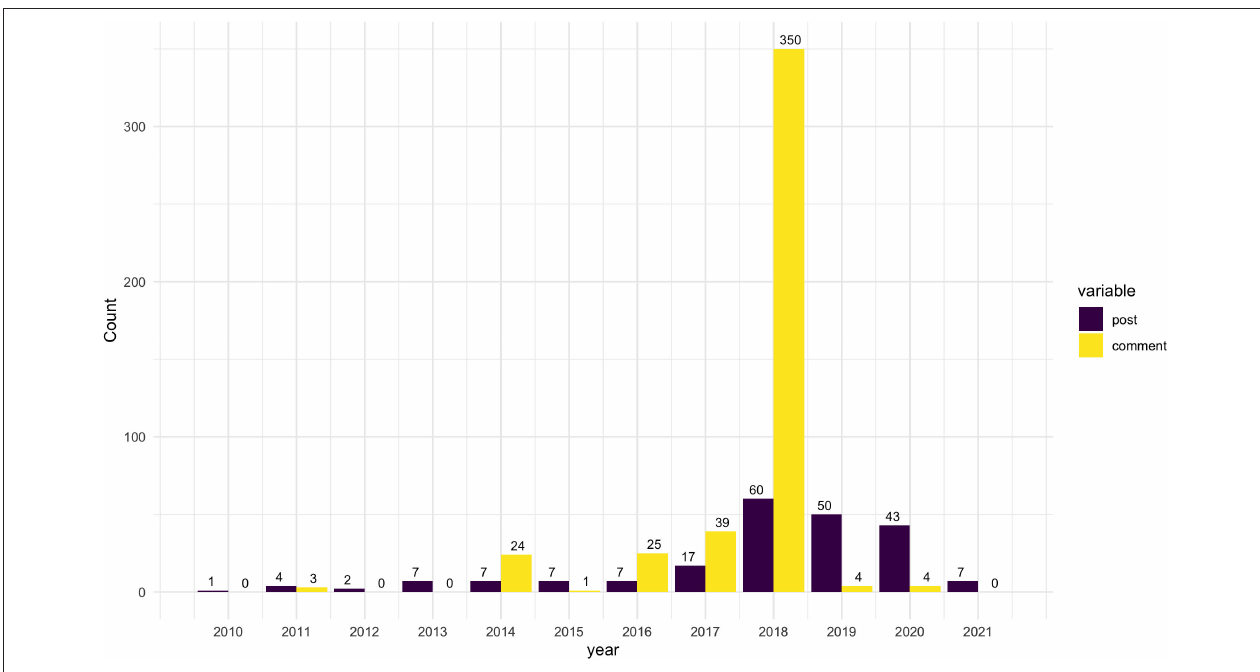
FIGURE 1 | The number of HPV vaccination-related posts and comments on Facebook per year from 2010 to 2021.